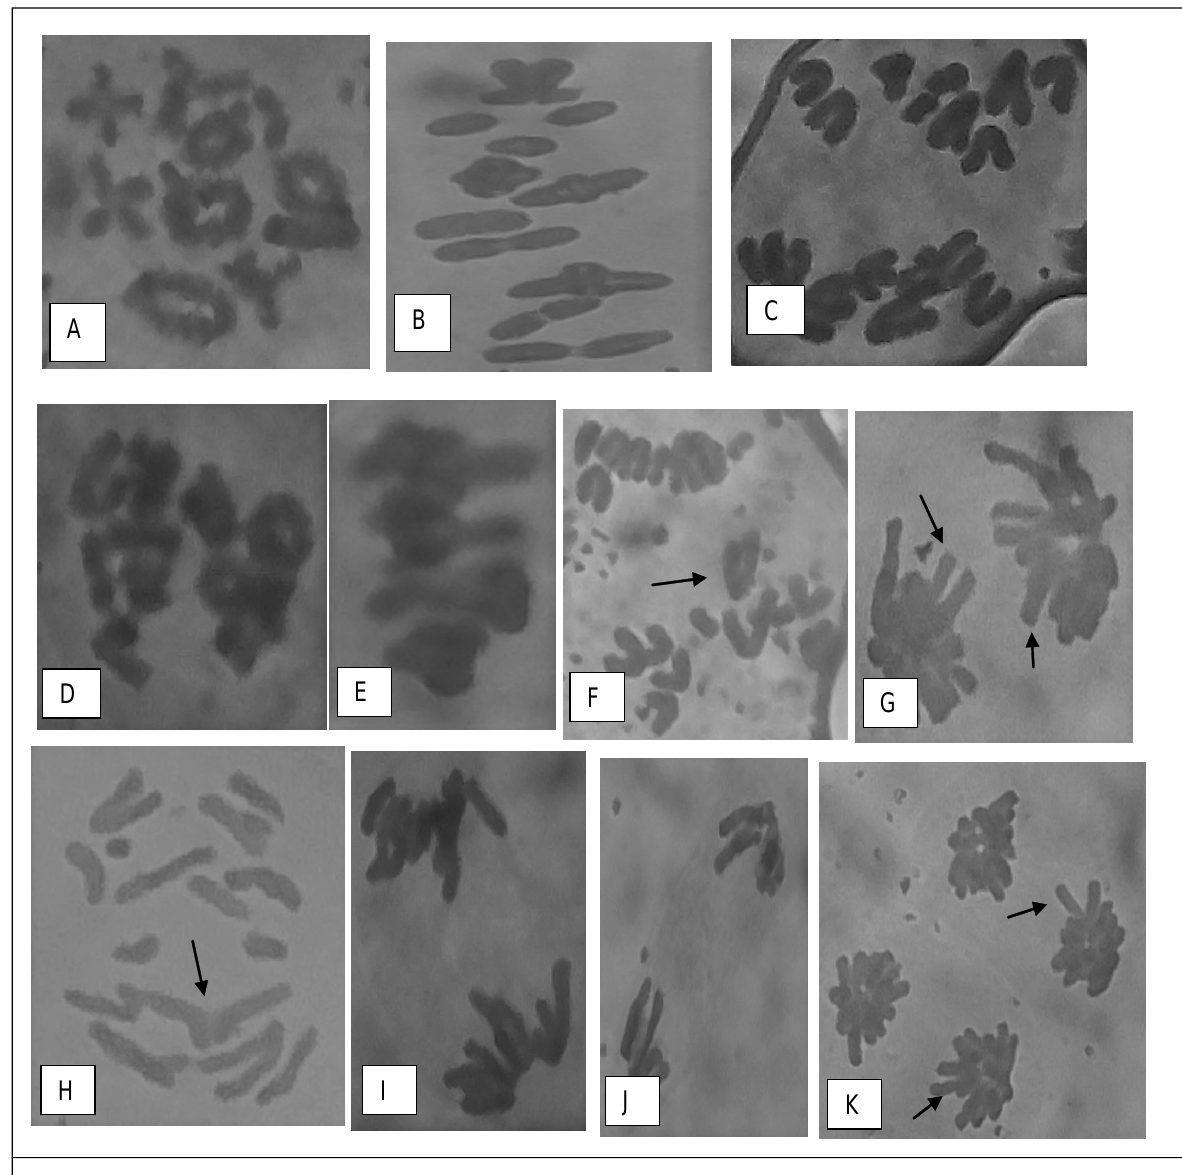
Figure 1: Meiotic chromosome abnormalities induced in Z. variegatus treated with aqueous leaf extracts of watermelon ( C. lanatus ): (A) = Normal Diplotene; (B) = Normal Metaphase – 1 (side view); (C) = Normal Anaphase – 1; (D) = Sticky Diplotene (Prophase-1); (E) = Sticky Metaphase – 1; (F) = Anaphase – 1 (Arrow indicating laggard); (G) = Early Telophase -1 (Arrow indicating laggards); (H) = Anaphase – 2 (Arrow indicating bridge); (I) = Sticky Anaphase – 2; (J) = Anaphase -2 (Chromosome loss); (K) = Telophase – 2 (Arrows indicating